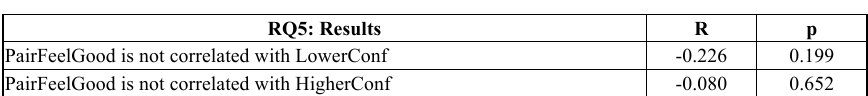
Results summary of RQ5 (extended)